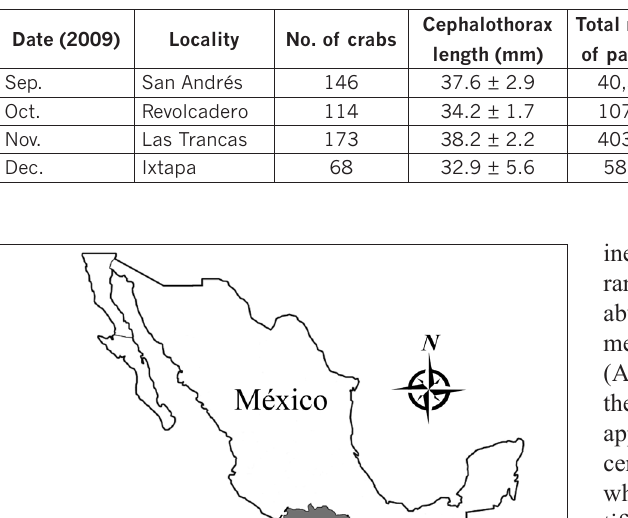
Table 1. Infection parameters of metacercariae of Microphallus nicolli in Emerita rathbunae from four coastal locations in Guer- rero, Mexico. Significant values for the relationship between crab size (cephalothorax length) and metacercariae abundance per infected host (r ) are in bold. P (%) = Prevalence of infection (% of infected crabs); Range of Intensity = minimum and maximum s number of metacercariae; r = Spearman’s correlation coefficient. s